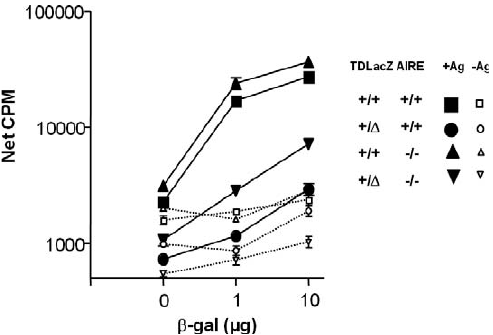
Figure 5. AIRE Is Not Necessary for Tolerance to Antigens Expressed by TSCOT þ TECs Proliferation assays in response to b -gal for lymph node CD4 þ T cells from LacZ-immunized (10 l g) wild-type (rectangles), TDLacZ (ovals), or AIRE-deficient (triangles), or from AIRE-deficient 3 TDLacZ (inverted triangles) mice. The responses of the LacZ-immunized mice ( þ Ag) are shown as solid lines with closed symbols, while those of the adjuvant- only immunized mice ( (cid:2) Ag) are shown as dotted lines with open symbols.